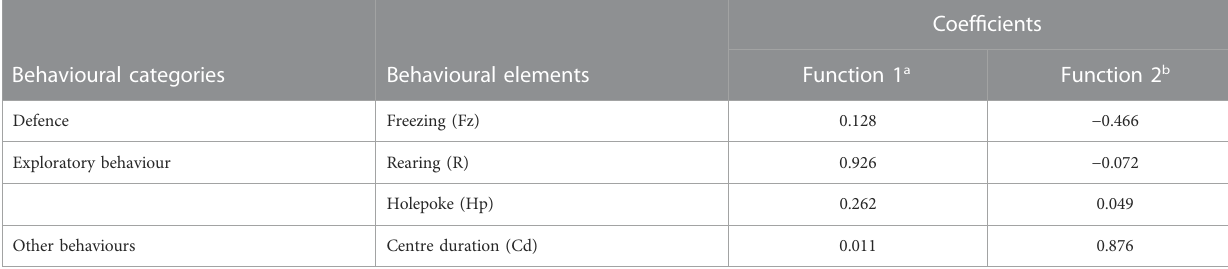
TABLE 1 Discriminant function coef fi cients of the main behavioural elements that determined the behavioural